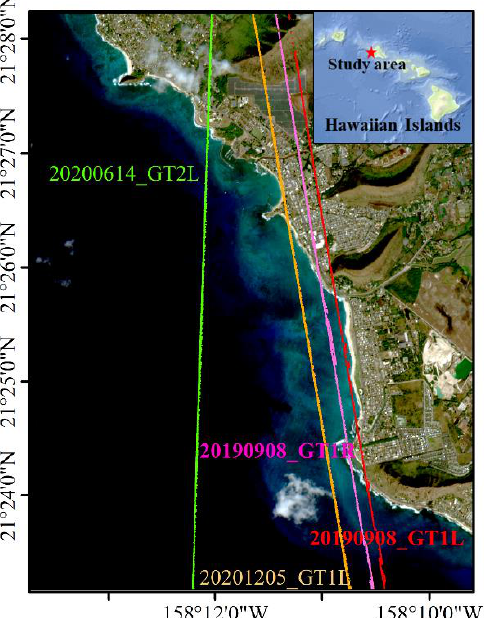
Figure 2. Map of the Oahu Island study area, which includes the ICESat-2 ground tracks. From left to right: 20200614GT2L, 20201205GT1L, 20190908GT1R, 20190908GT1L. to right: 20200614GT2L, 20201205GT1L, 20190908GT1R,